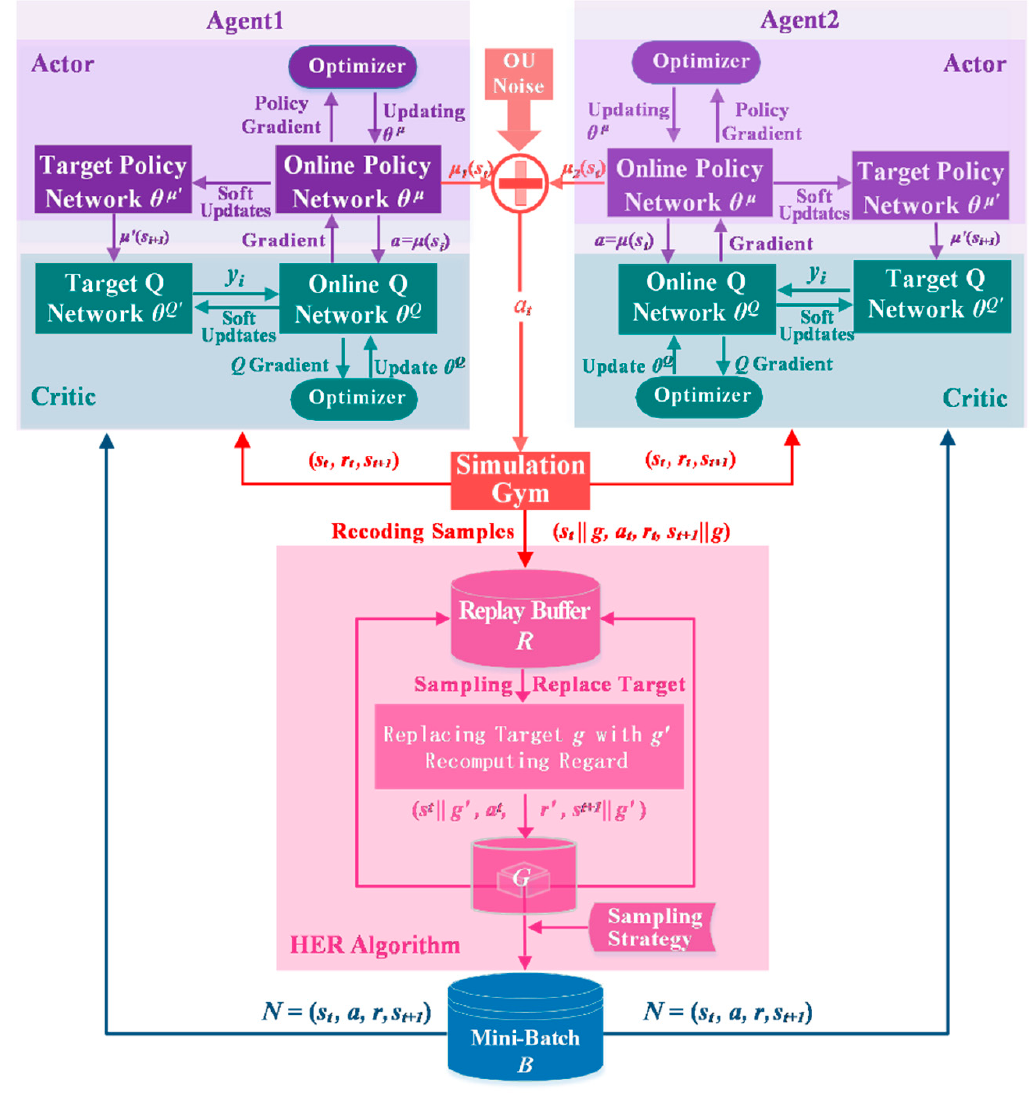
Figure 1. The block diagram for the dual-arm deep deterministic policy gradient (DADDPG) algorithm. More specifically, each of the two mechanical arms has an agent, and they interact within the same environment. The training algorithm for each agent is DDPG. At each timestep, each agent i takes an action a i to interact with the environment; the joint action leads to a new state, and each agent i receives their own separate observations o i . However, in order to achieve cooperation between the two arms, a collaborative mechanism of re- warding coordination and punishing competition is introduced. The agents can share